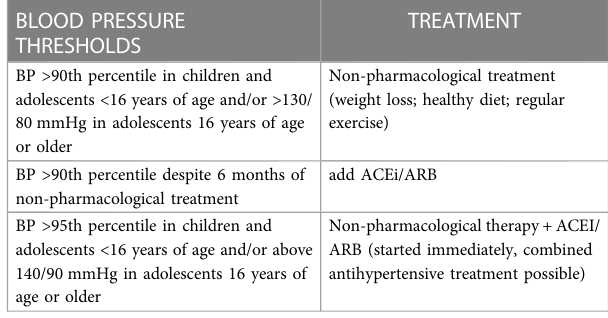
TABLE 10 Principles of antihypertensive therapy in children with diabetes mellitus type 1 or 2 (grade